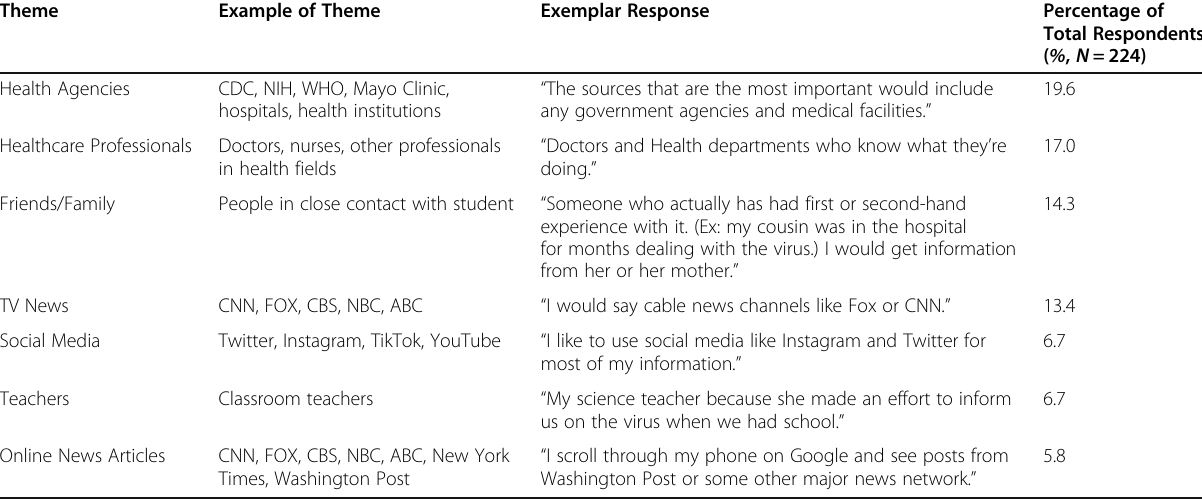
Table 2 Thematic Analysis of Student Sources for COVID-19 Information